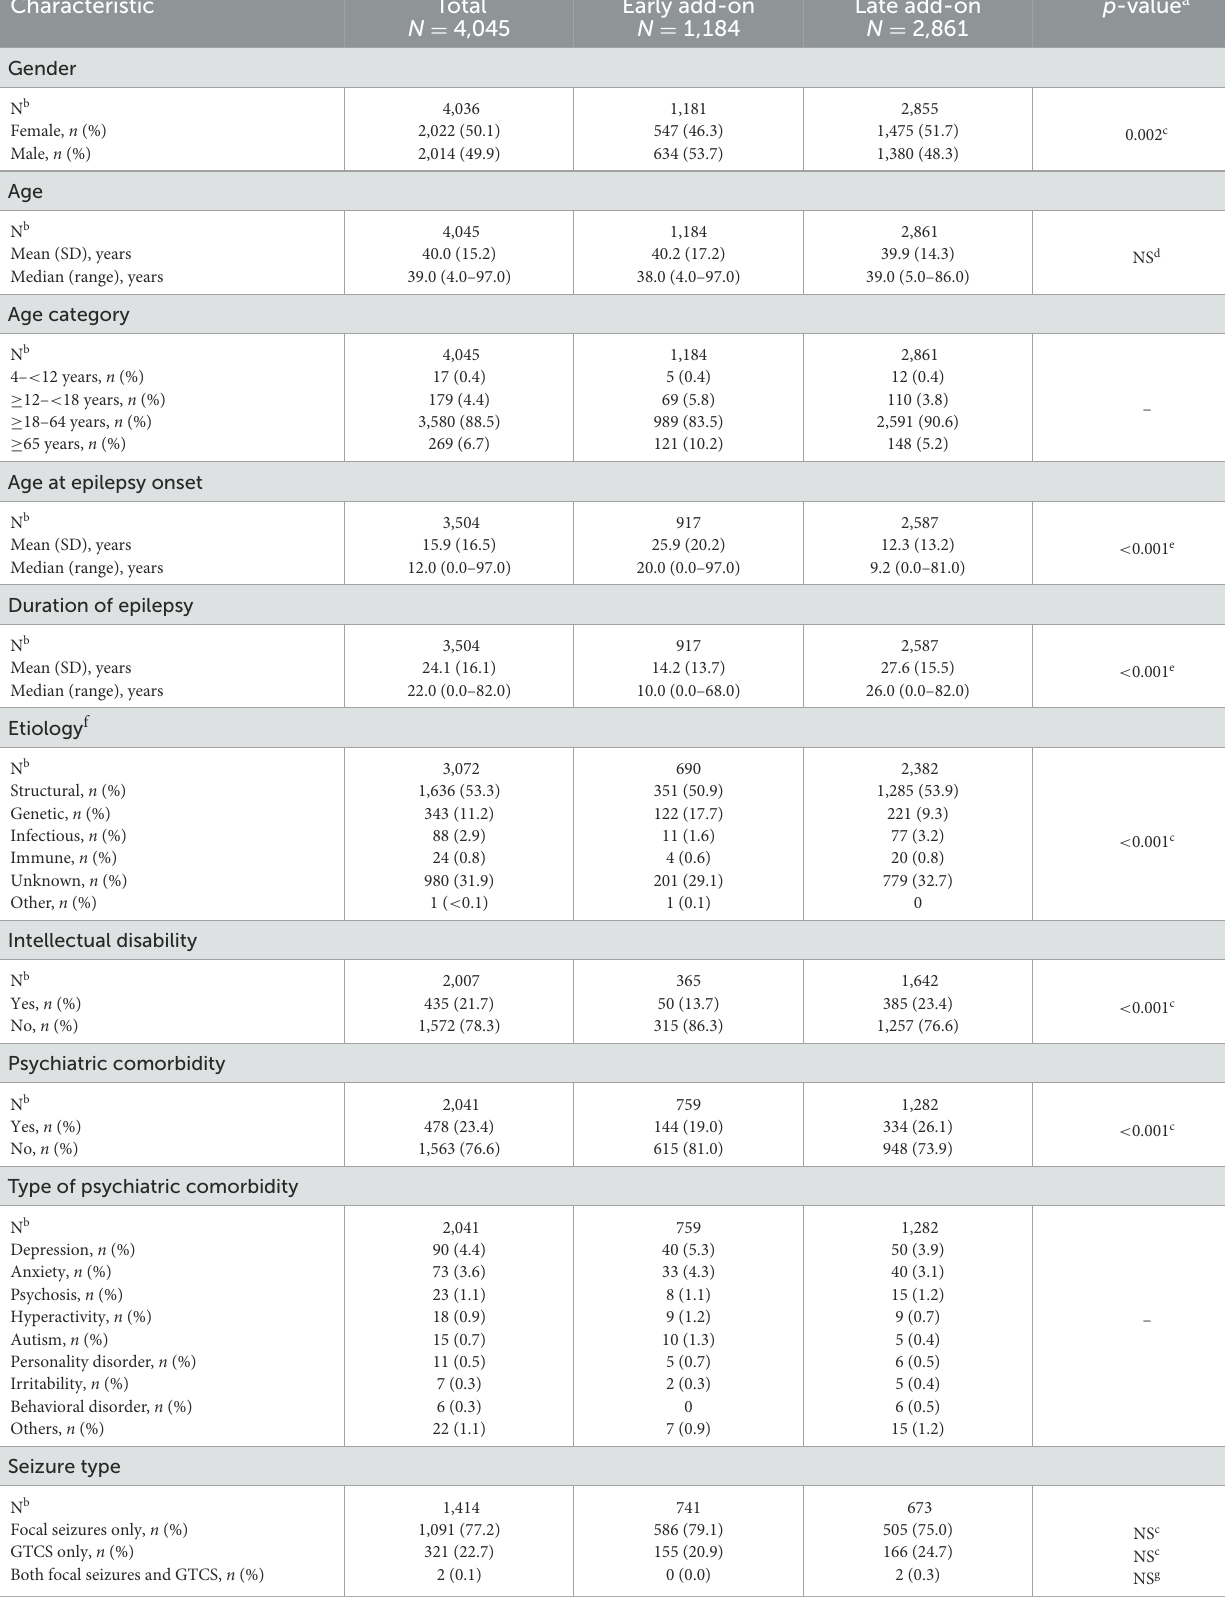
TABLE 1 Demographic and baseline characteristics (full analysis set). Characteristic Total